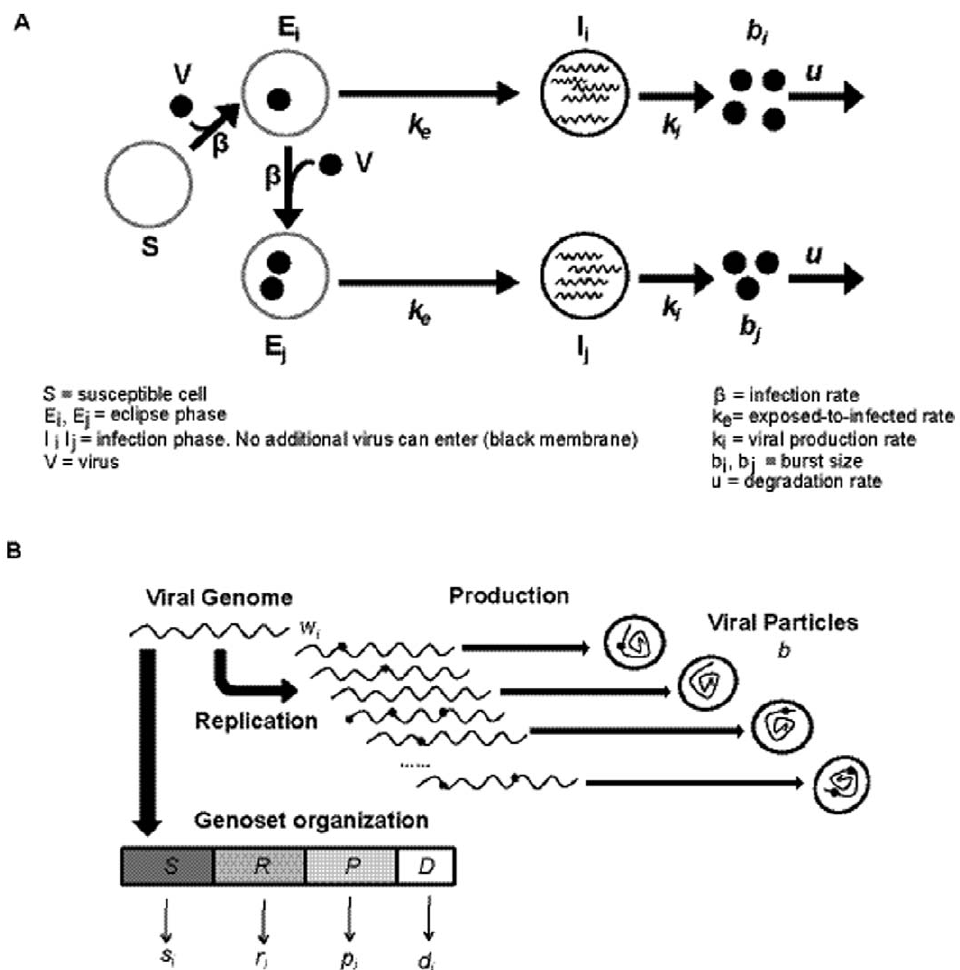
Figure 3. Basic features of the genosets model of lethal defection. A. Scheme of the infection of susceptible cells (S) by LCMV (V), stages of the infection process, and main parameters involved in the model (further detailed in the text and in Text S1). B. Scheme of the intracellular dynamics (excluding transcription) with formation of mutant genomes (dots on wavy lines) that may or may not be encapsidated. The boxes depict the genoset organization, which does not fit the physical map of the LCMV genome (see text), and which forms the conceptual basis of the extended lethal defection model presented here.